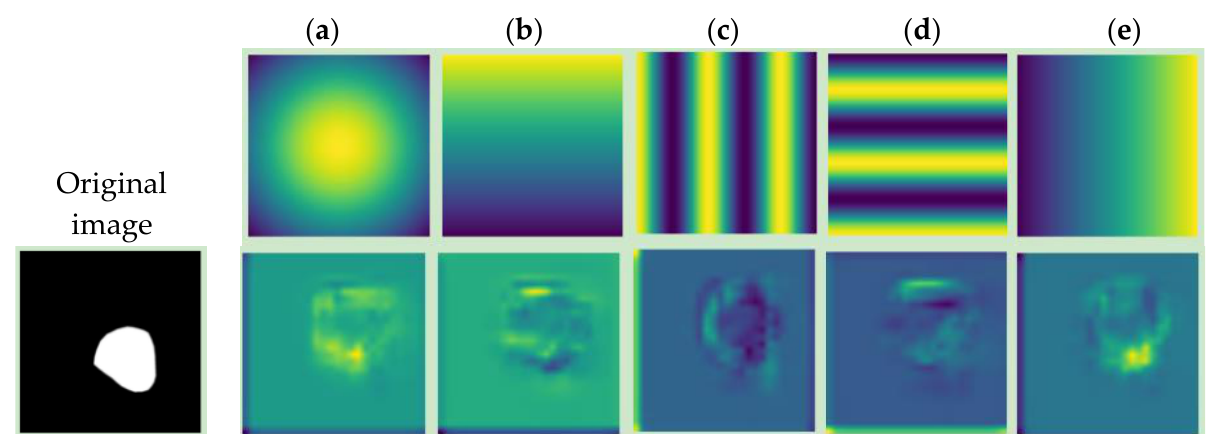
Figure 4. Gradient-like ground-truth position maps. ( a – e ) Different weight masks and their weighted graphs